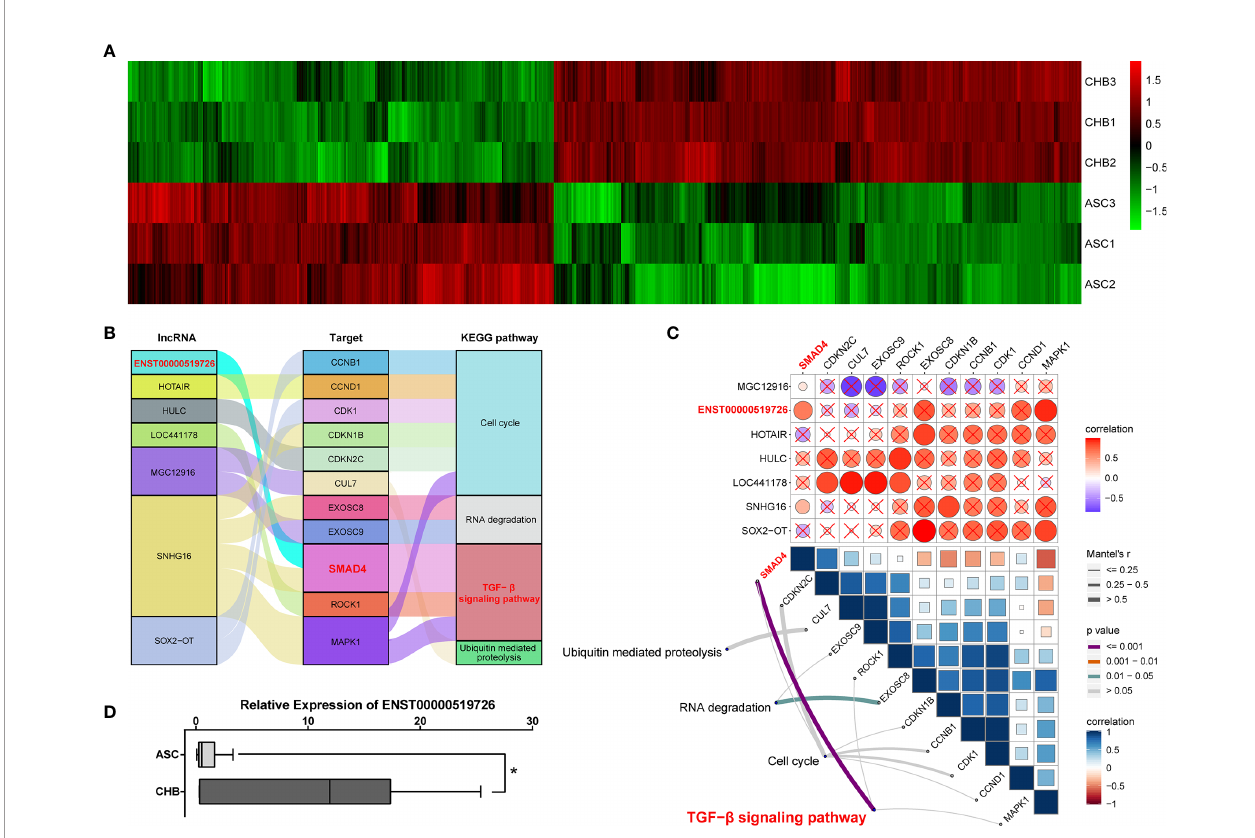
FIGURE 2 | Identi fi cation of differentially expressed lncRNAs correlated with TGF- b signaling pathway in long-term CHB patients. (A) Hierarchical clustering analysis of 4,718 differentially expressed lncRNA transcripts between CHB with long-term antiviral treatment and ASC samples (fold change >2, up- or down-regulated). Columns represent each gene, and rows represent each sample. The relative expression levels of mRNAs are depicted into color scale ranging from green (down- regulated) to red (up-regulated). (B) Alluvial diagram of candidate differentially expressed lncRNAs with up-regulated mRNAs from enriched KEGG pathways. (C) Pairwise correlations between lncRNAs and mRNAs (upper), with a color gradient denoting Pearson correlation coef fi cients. Pairwise comparisons between lncRNAs and mRNAs (lower). Edge width corresponds to the Mantel ’ s r statistic, and edge color denotes the statistical signi fi cance. (D) Real-time PCR validation of lncRNA ENST00000519726 in ASC or CHB samples. ∗ p <